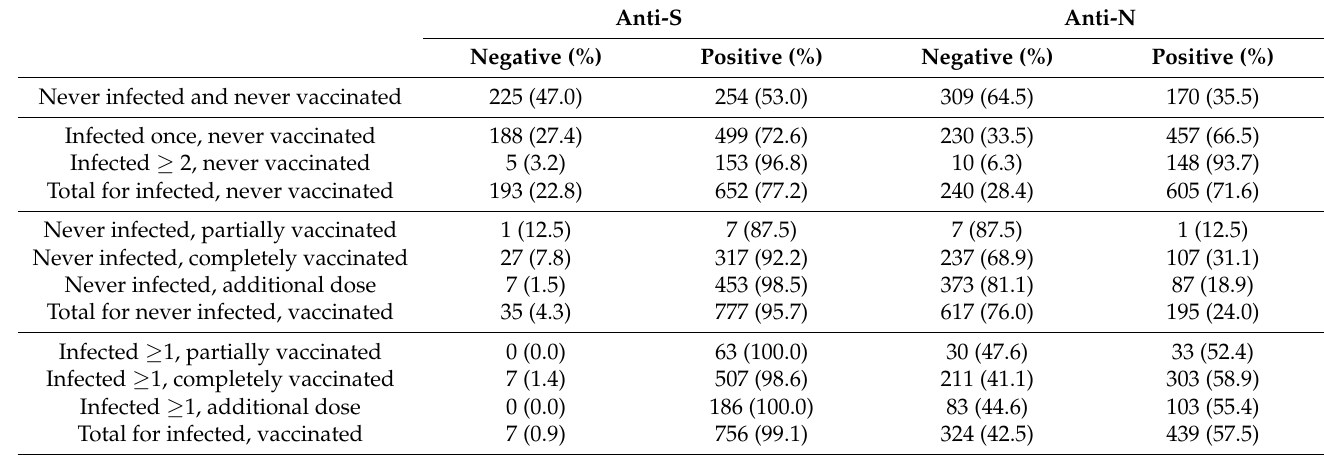
Table 2. Seropositivity of anti-S and anti-N antibodies in participants stratified according to vac- cination status and SARS-CoV-2 RT-PCR or RAT positivity recorded in the National COVID-19 Database.